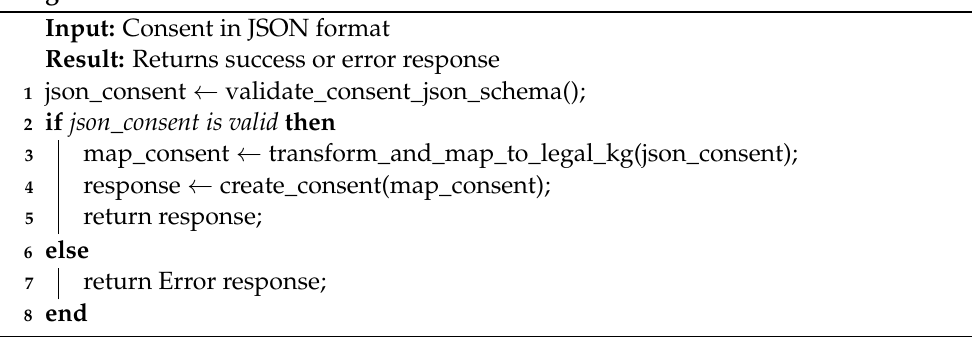
Algorithm 2: Consent validation for consent